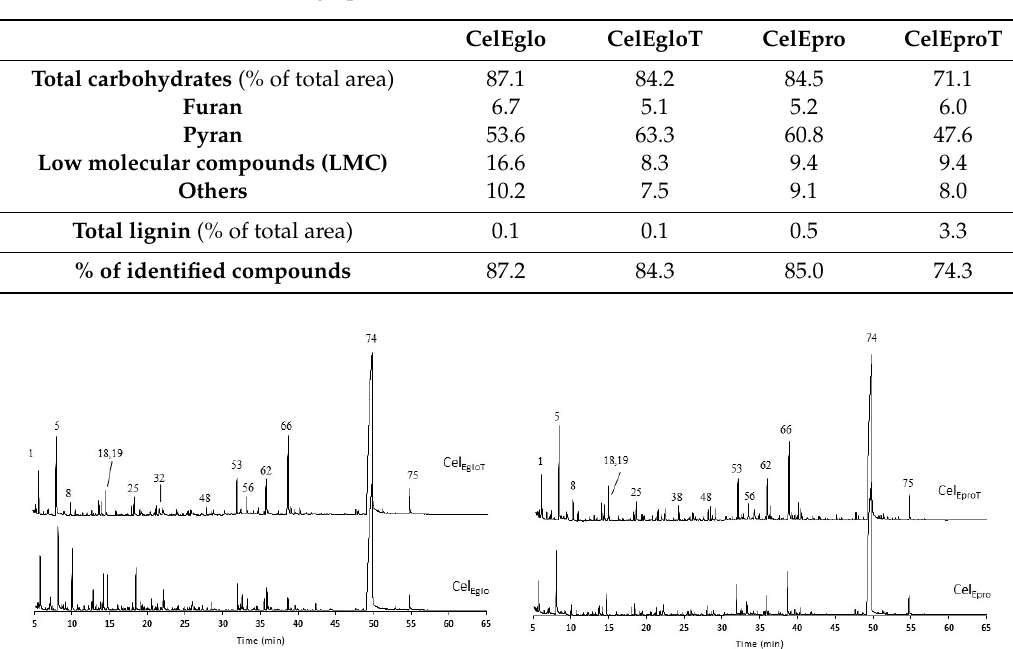
Table 6. Pyrolysis results of the isolated celluloses from E. globulus , E. propinqua before and after thermal treatment (% of total chromatographic area).